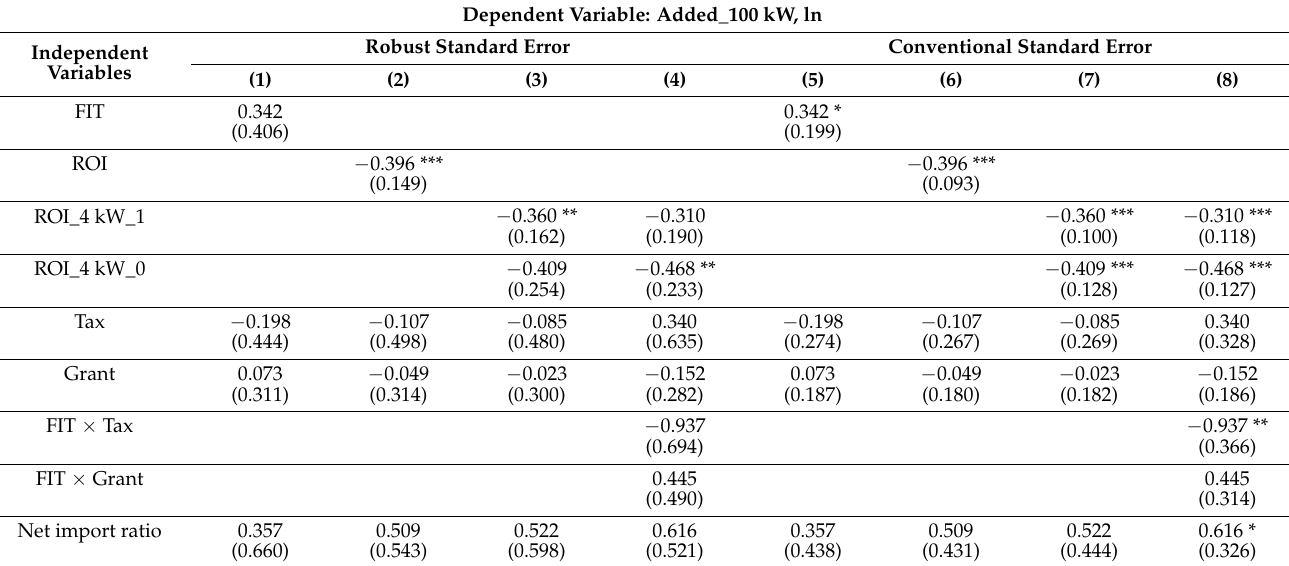
Table A4. Random effects estimation results for solar PV on the commercial